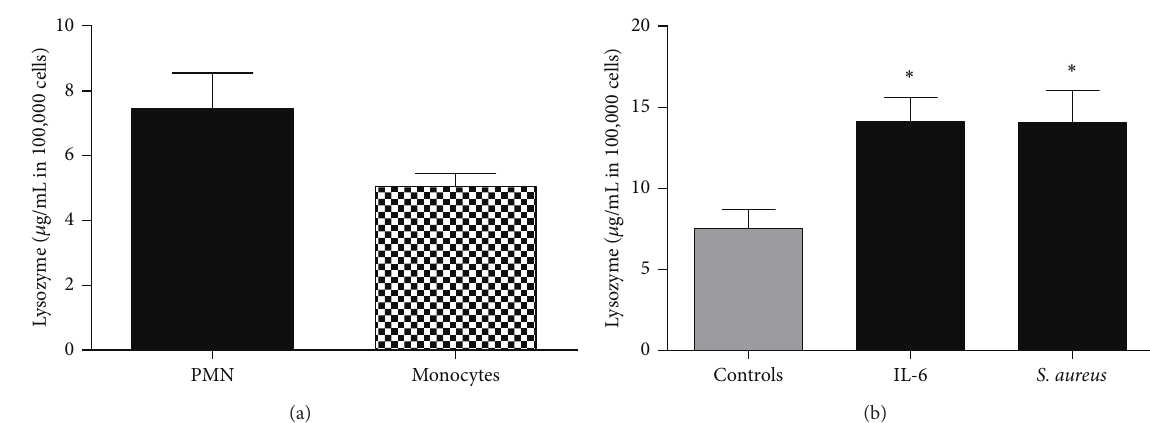
Figure 3: Lysozyme expression in PMN and monocytes . (a) Polymorphonuclear cells (PMN) and monocytes were isolated from whole blood of healthy donors and lysed cells were detected for lysozyme concentration by ELISA. PMN contain higher levels compared to monocytes. (b) PMN were incubated with 50ng/ml IL-6 and SA (supernatant 1:100); ∗ 𝑃 < 0.01 .